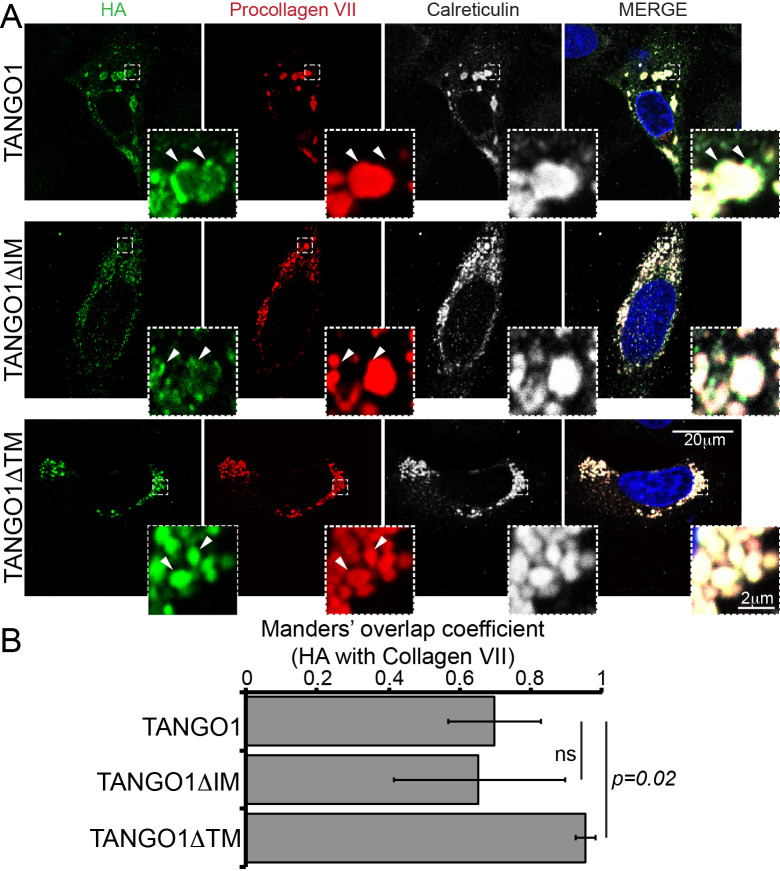
Deletion of the intramembrane has no effect on TANGO1 recruitment to collagen.(A) TANGO1 or TANGO1ΔIM (green) form distinct puncta at procollagen VII (red) accumulations in the ER (ER marker calreticulin in white). TANGO1 lacking a transmembrane domain (TANGO1ΔTM) does not form ERES puncta at procollagen VII accumulations; instead it uniformly coats the collagen. Arrowheads indicate representative features in each channel. Scale bar: 20 μm, Inset: 2 μm. (B) Plot of the Manders’ colocalization coefficients of the extent of overlap of HA (TANGO1 constructs) with procollagen VII. ns: not significant, p<0.02 by Student’s t test.